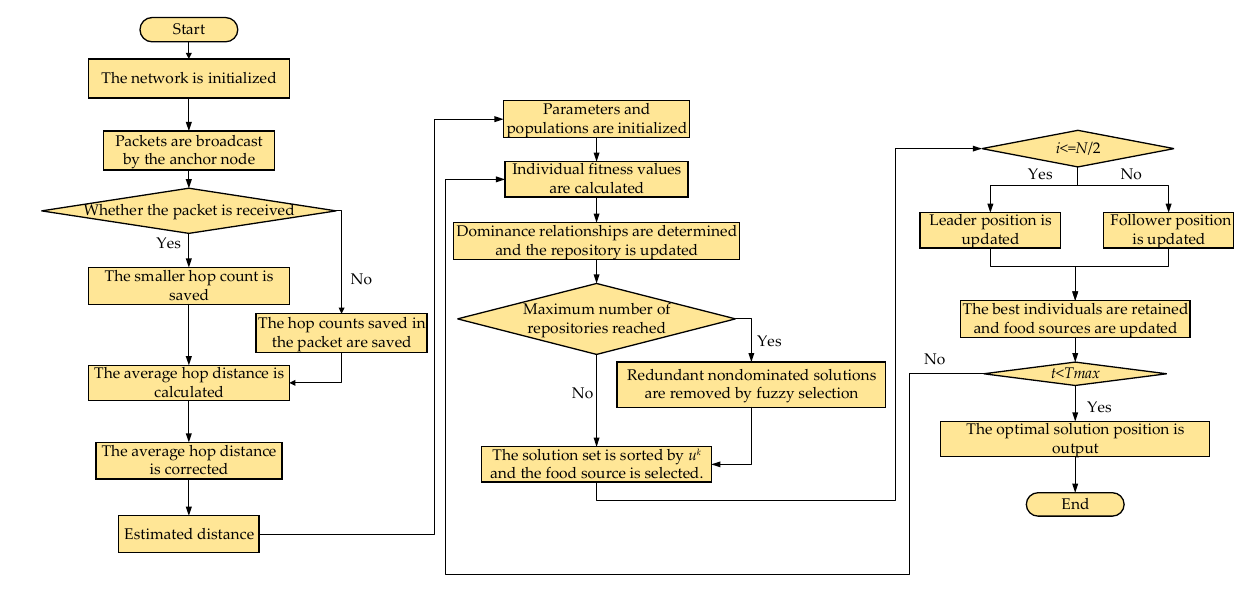
Figure 1. Flow chart of IMSSA-DV-Hop algorithm.